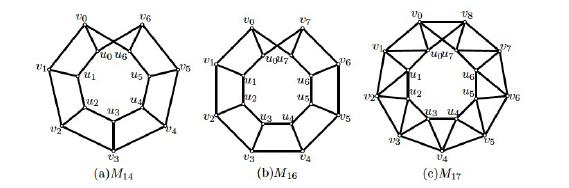
Figure 1. Examples of Möbius